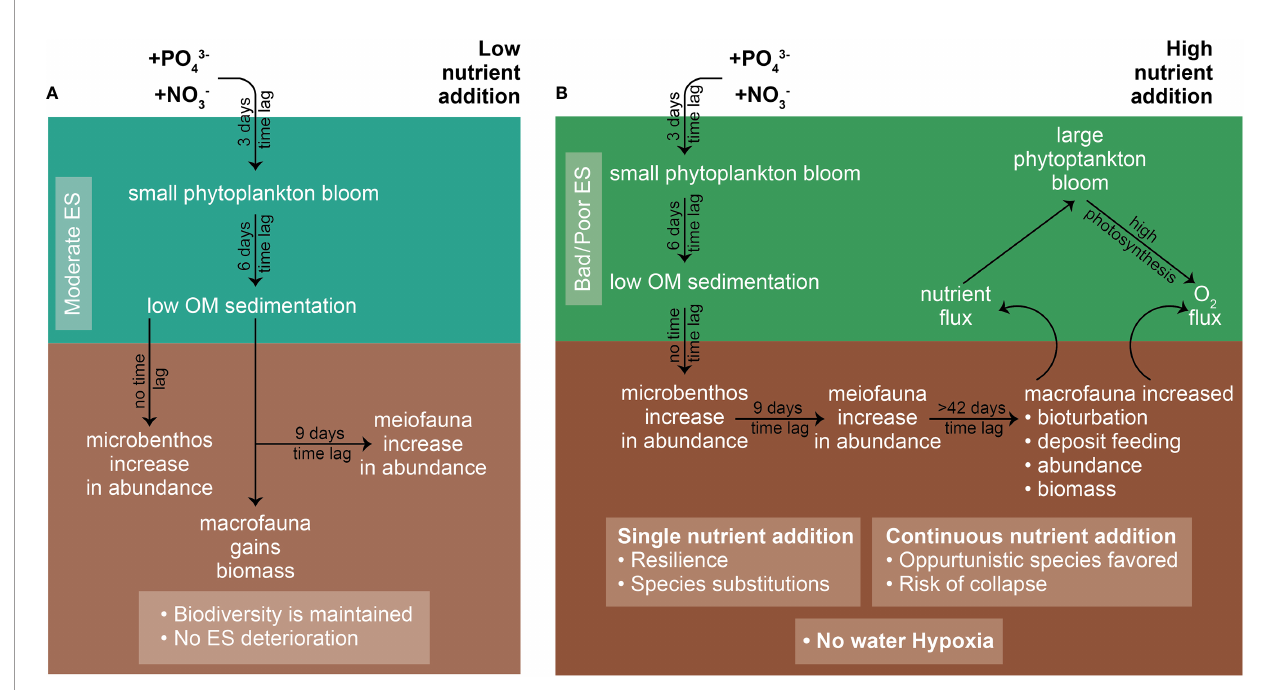
FIGURE 2 | Schematic representation of the benthic – pelagic succession pattern under two different scenarios. (A) Low nutrient addition. (B) High nutrient addition (single or